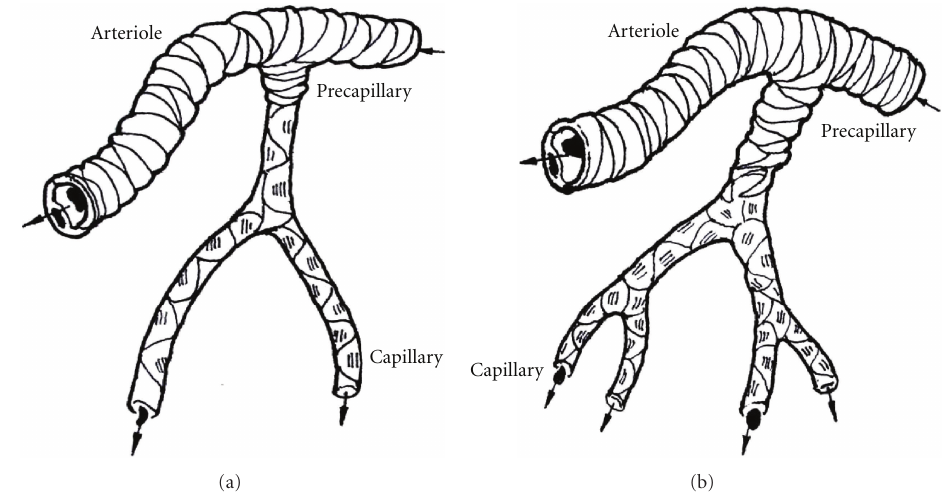
Figure 6: Illustration of precapillary transformation into arterioles. (a) Precapillaries before the increase of blood flow; (b) precapillaries after the expansion of capillary